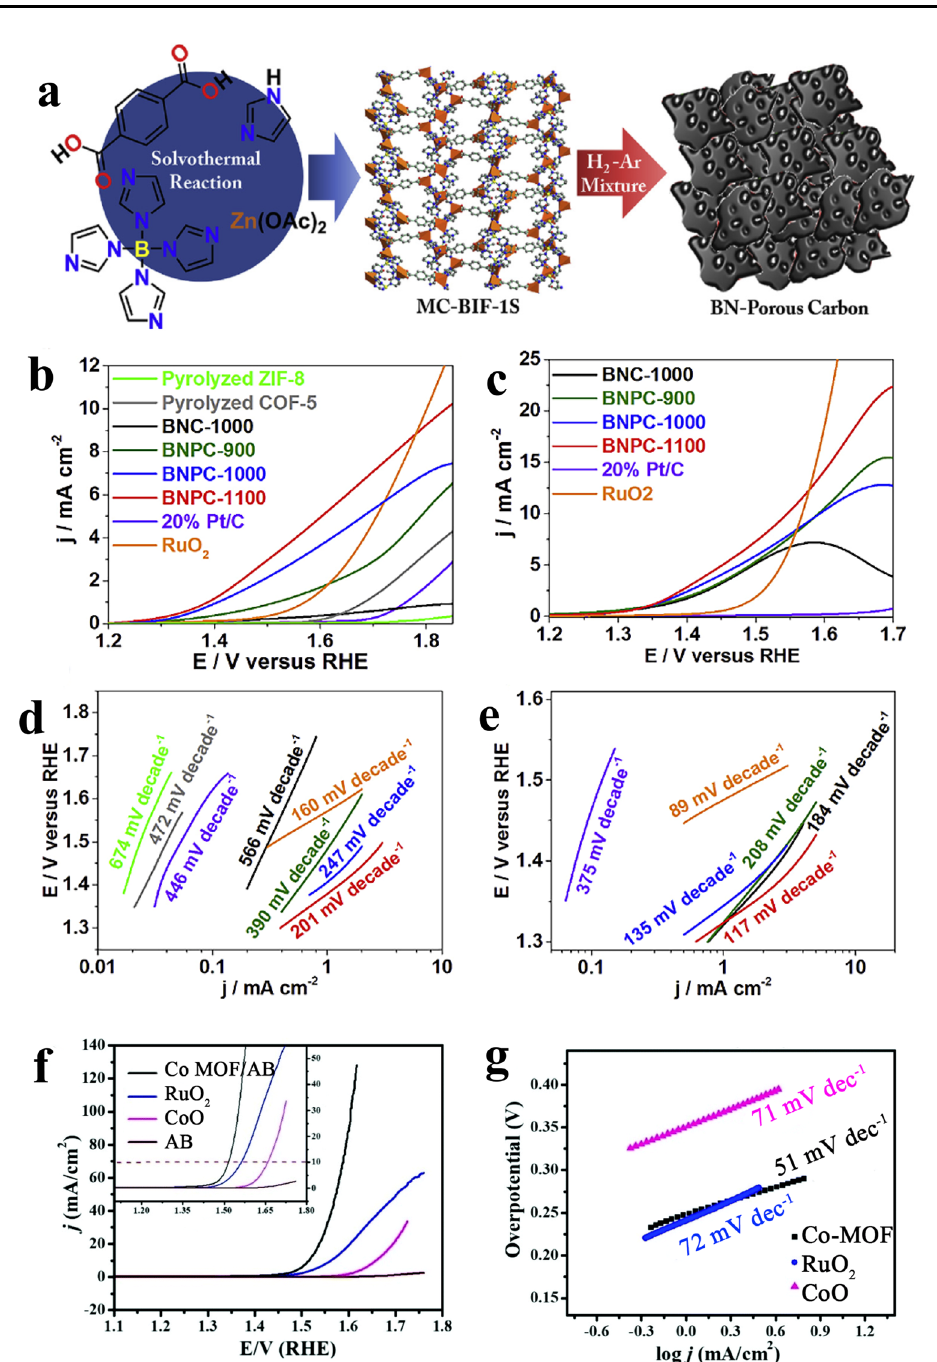
Fig. 8 a Synthetic scheme of BNPCs, LSV. b, d Tafel plots of pyrolyzed non-B-doped MOFs, BNC, BNPCs, 20% Pt/C, and RuO 2 in 0.1 M KOH and c, e 6 M KOH [77], Copyright© 2017, Elsevier. f LSVs for the OER by Co-MOF/AB, commercial RuO 2 , CoO (after TGA), and AB in a 1 M KOH electrolyte at the sweep rate of 5 mV s −1 and g the corresponding Tafel plot [153], Copyright © 2019, The Royal Society of Chem-